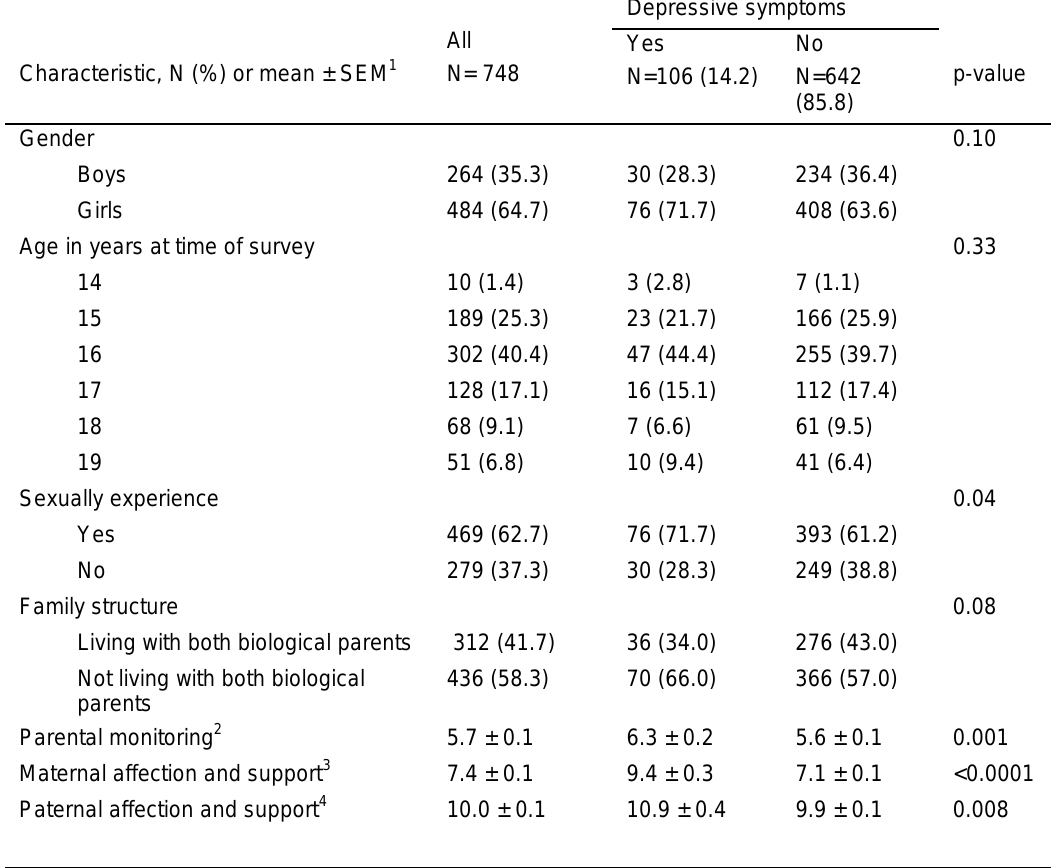
Individual and family characteristics of participants by depressive symptoms Depressive